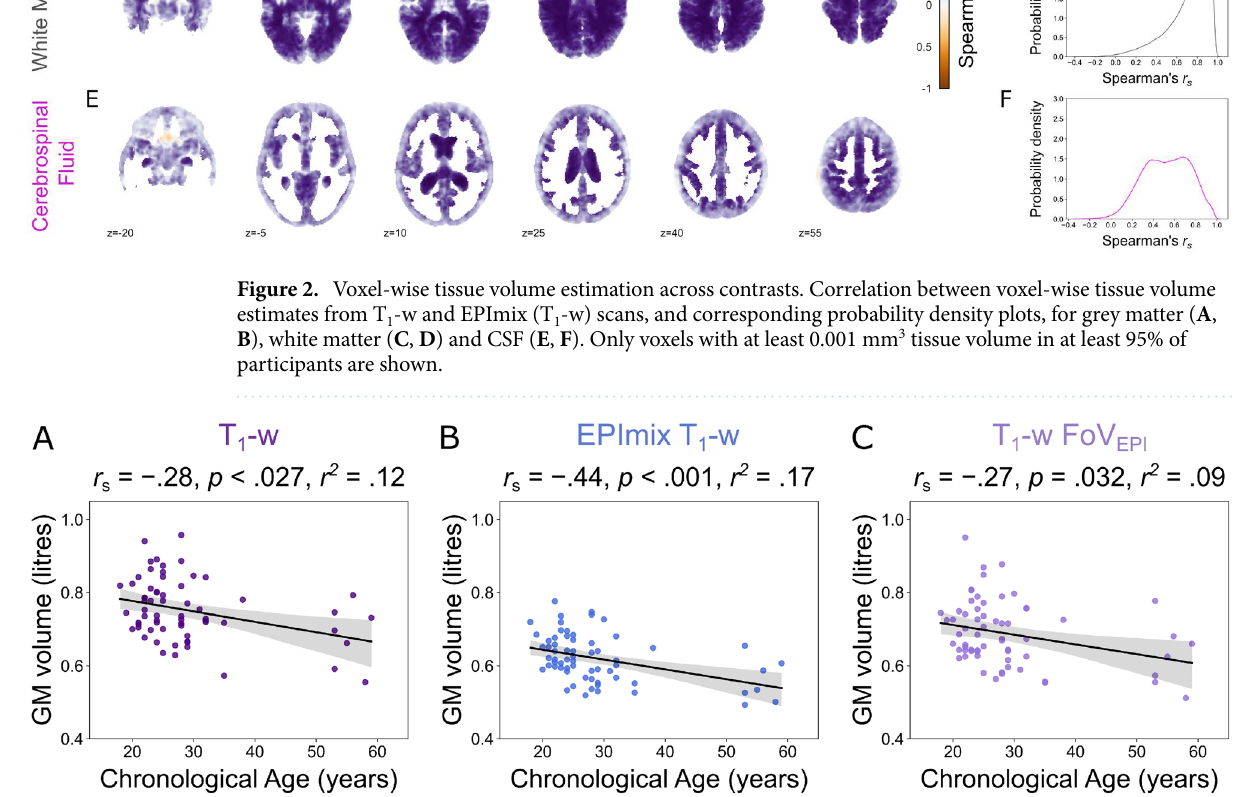
Figure 3. Grey matter volume as a function of chronological age, using volume estimates derived from ( A ) T 1 -w scans, ( B ) EPImix T 1 -w scans and ( C ) T 1 -w scans with reduced field of